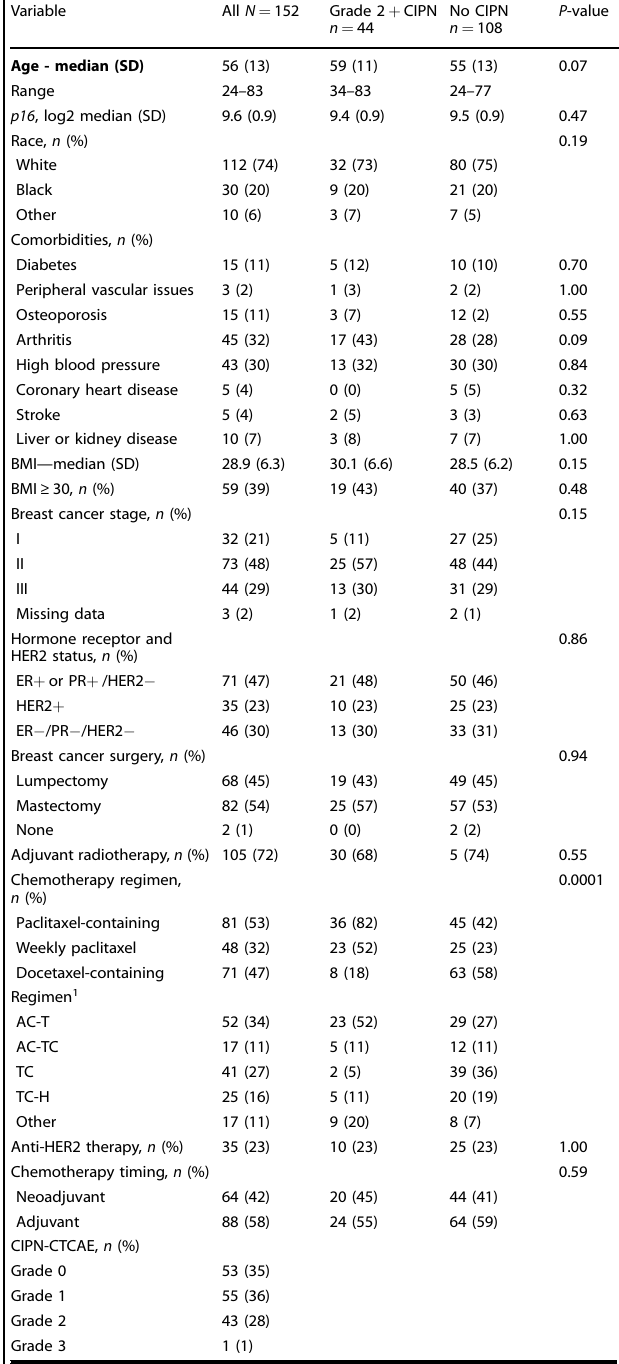
Table 1. Demographic and clinical characteristics of the participants in this